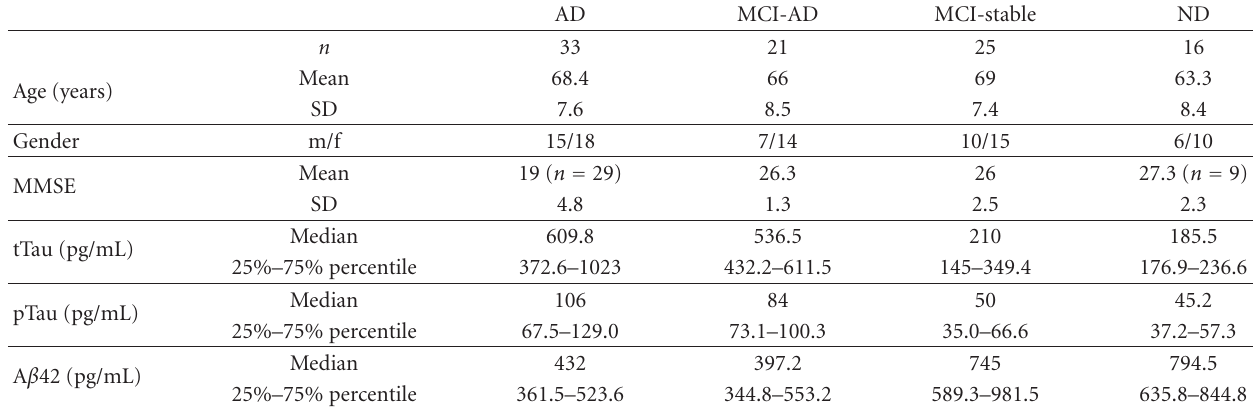
Table 1: Demographical data, MMSE scores, and classical CSF biomarkers ∗ .